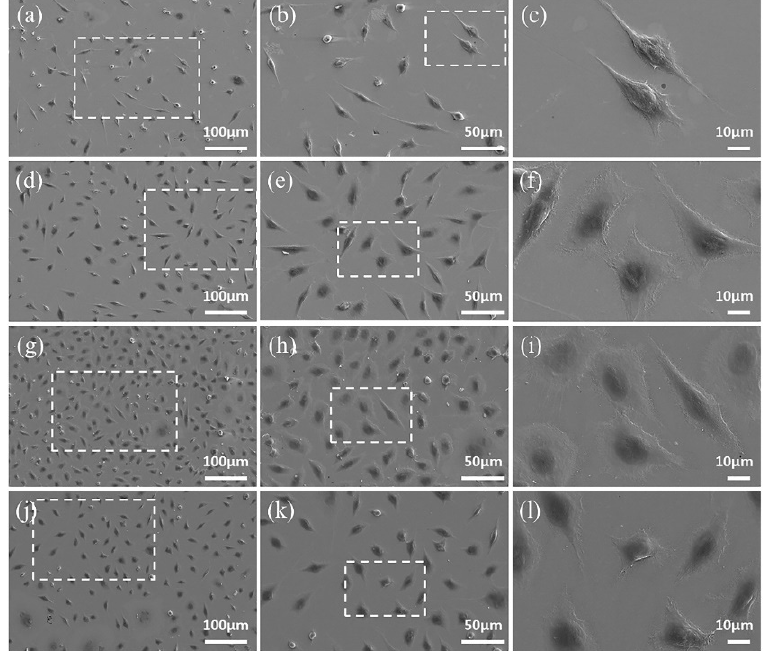
Figure 11. FE-SEM images of L-929 cells after culturing on CAST samples for 3 d ( a – c ) and 5 d ( g – i ), and on SLM samples for 3 d ( d – f ) and 5 d ( j – l ). The images obtained at higher magnification are taken from the areas enclosed by a square in the images taken at lower magnification.